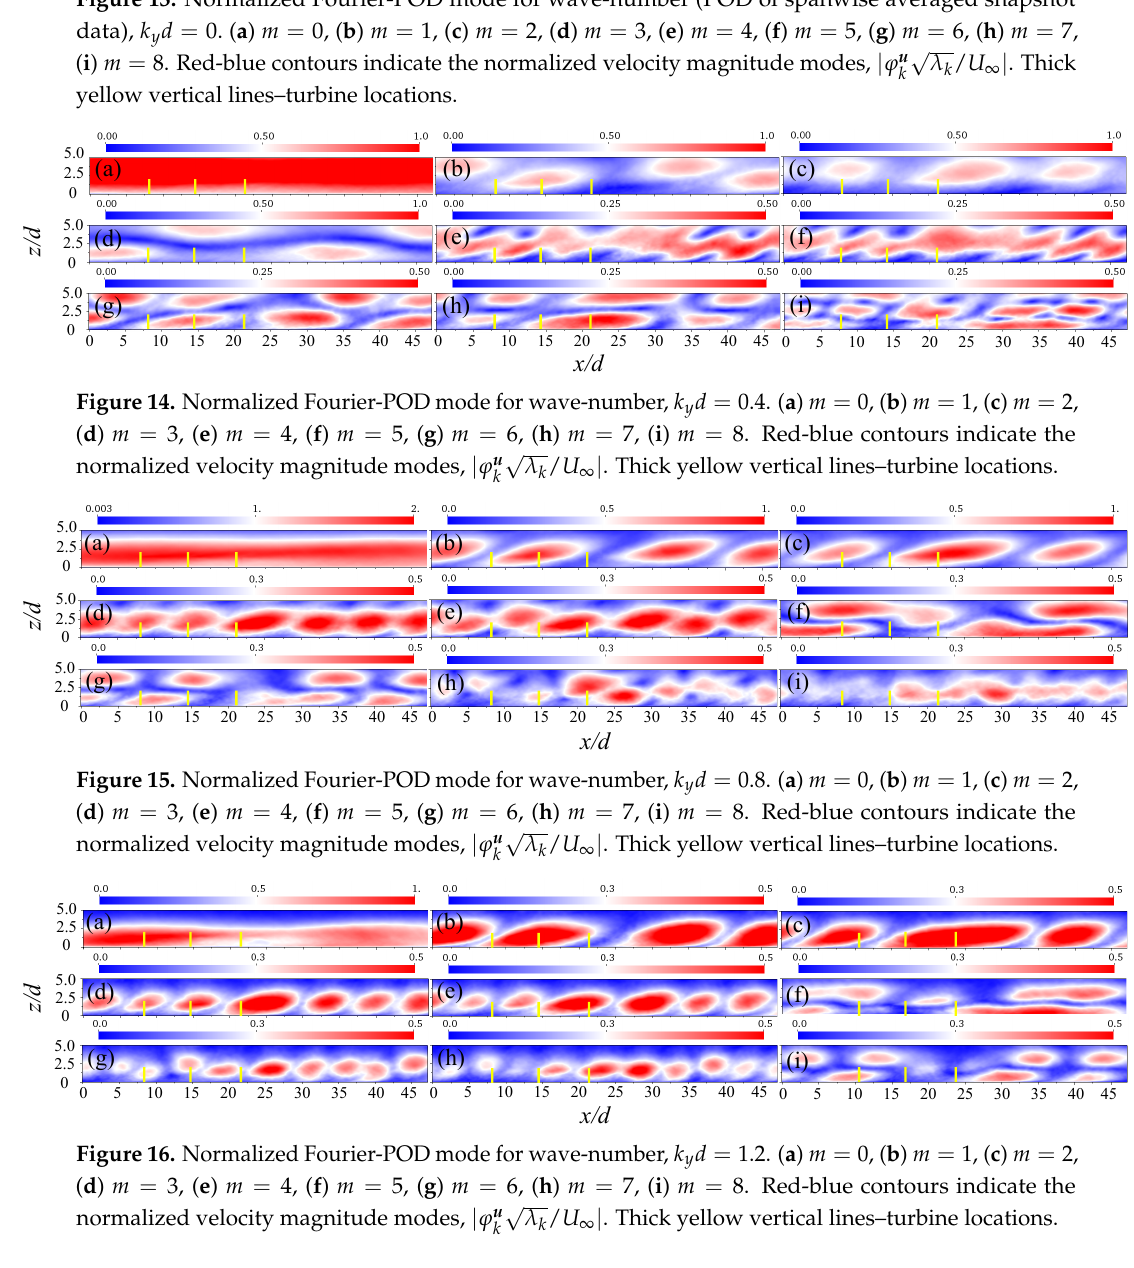
√ λ ϕ u k / U ∞ | . Thick k |